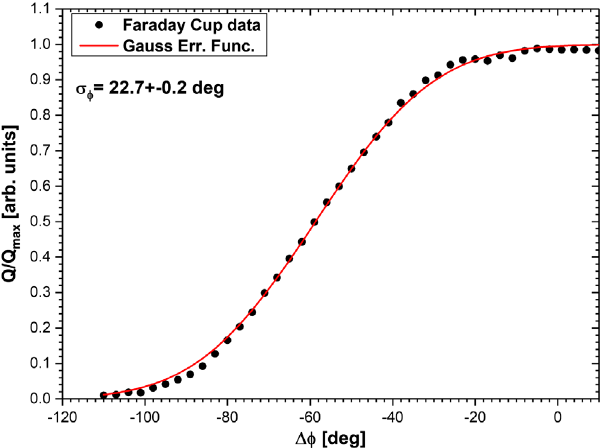
2594.FIG. 4. The transmission curve of the DTL 1,2 acceptance scan and its approximation by the formula (1) for the Rb4 effective voltage 103 kV.